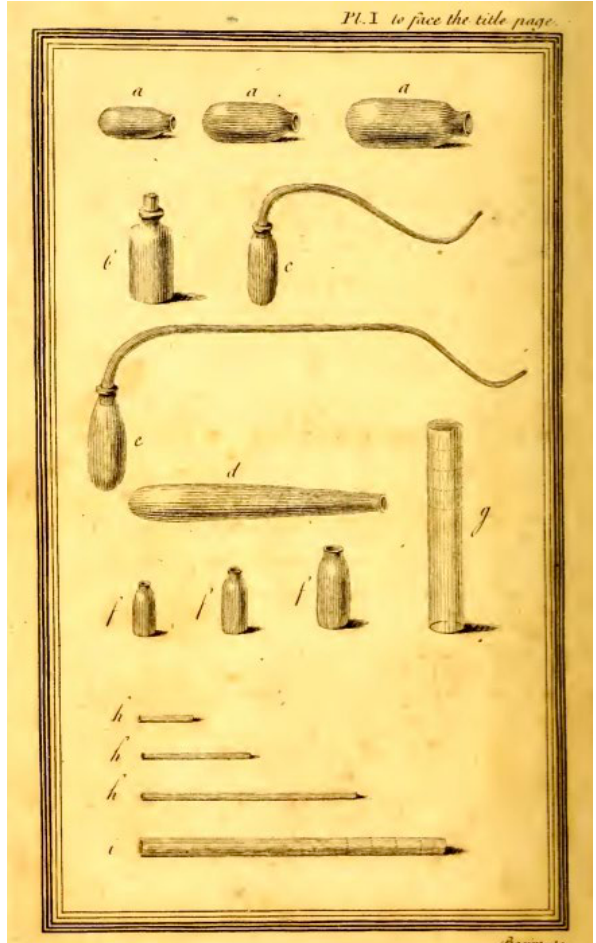
Figure 1. Priestley’s glass vials used for eudiometrical measure- ments. From Joseph Priestley, Experiments and Observations of Dif- ferent Kinds of Air (London, 1776), plate